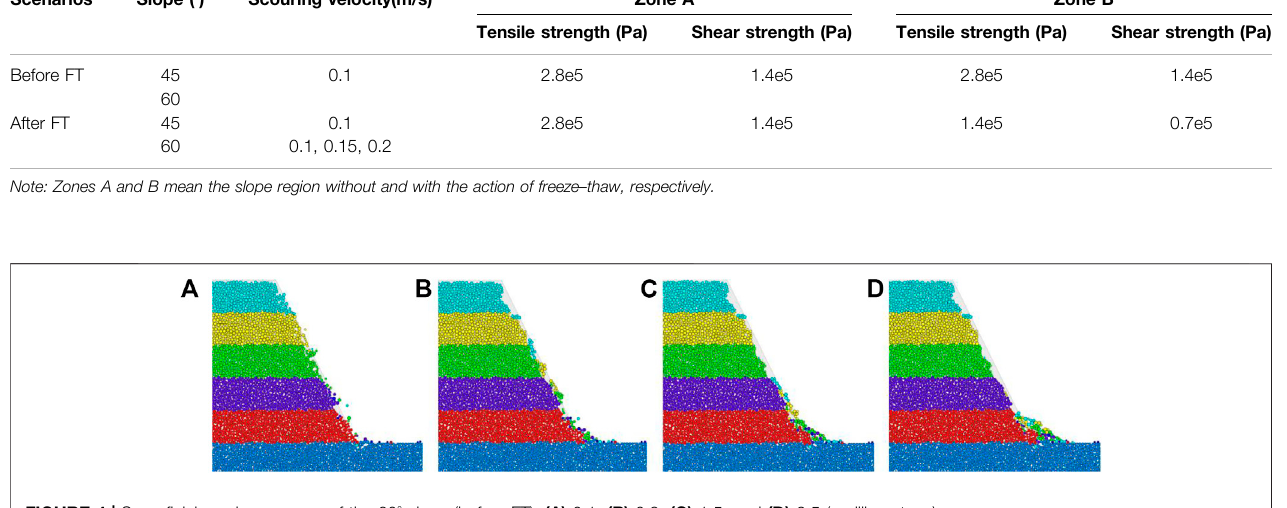
TABLE 1 | Simulation scheme and main parameters.